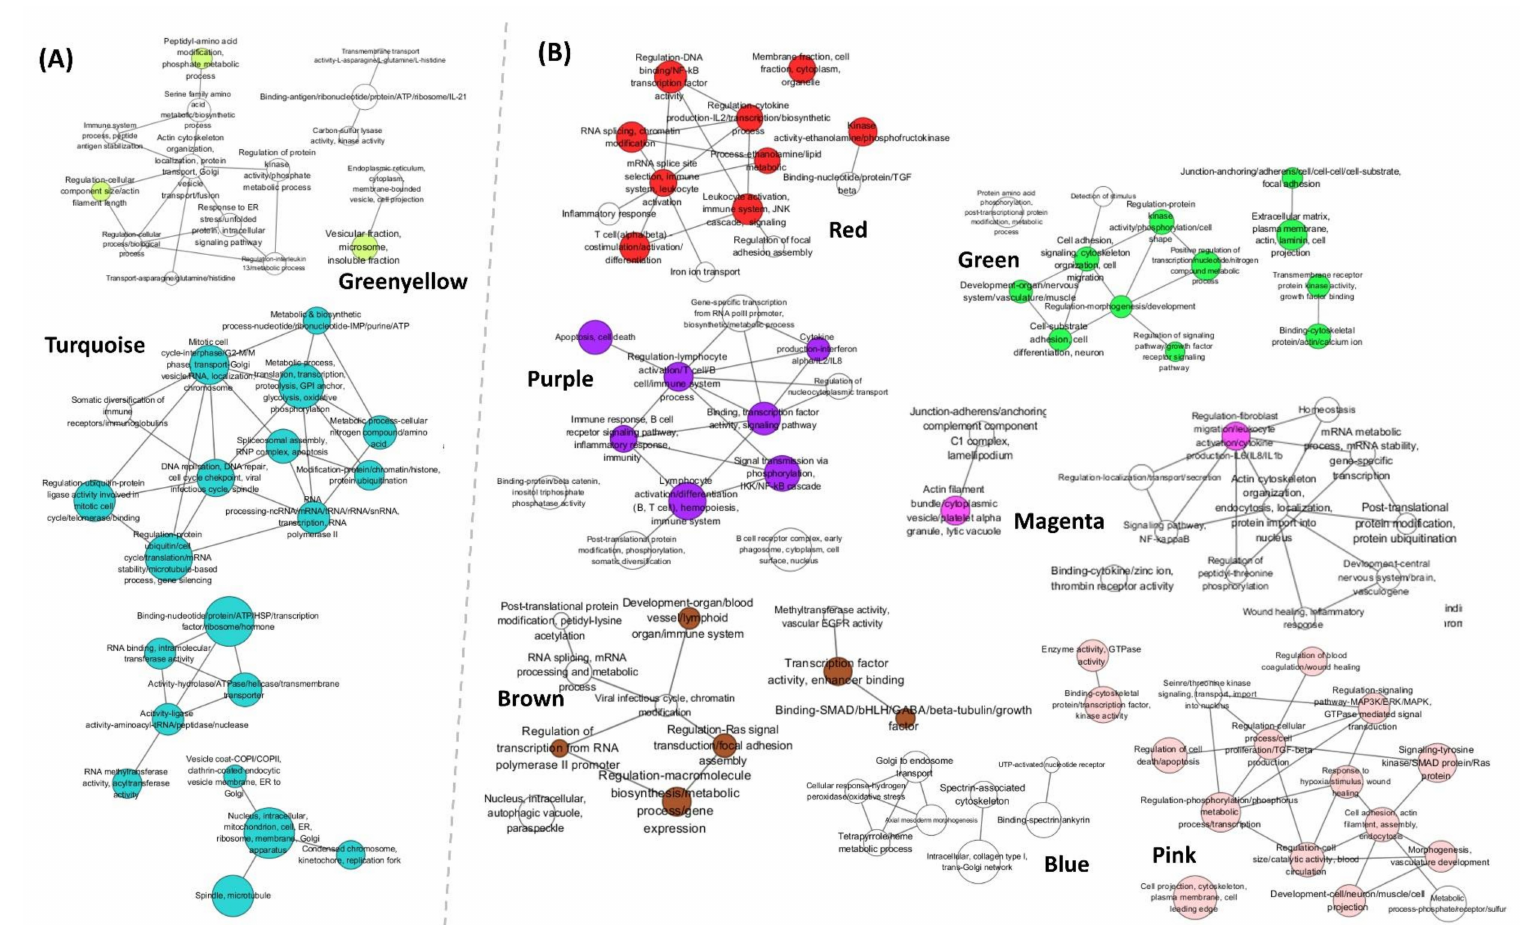
Figure 4. GO over-representation analysis results of positive ( A ) and negative ( B ) modules. Enriched GO terms by BiNGO (adjusted p -value < 0.05) were clustered by AutoAnnotate (version 1.2) with community cluster (GLay) algorithm in ClusterMaker2 (version 1.2.1) and annotated with WordCloud (version 3.1.2) in Cytoscape. Adjusted p -value was corrected using a Benjamini and Hochberg False Discovery Rate (FDR). Node size and color indicate the number of enriched GO terms and module color, respectively. The edge between nodes means presence of shared